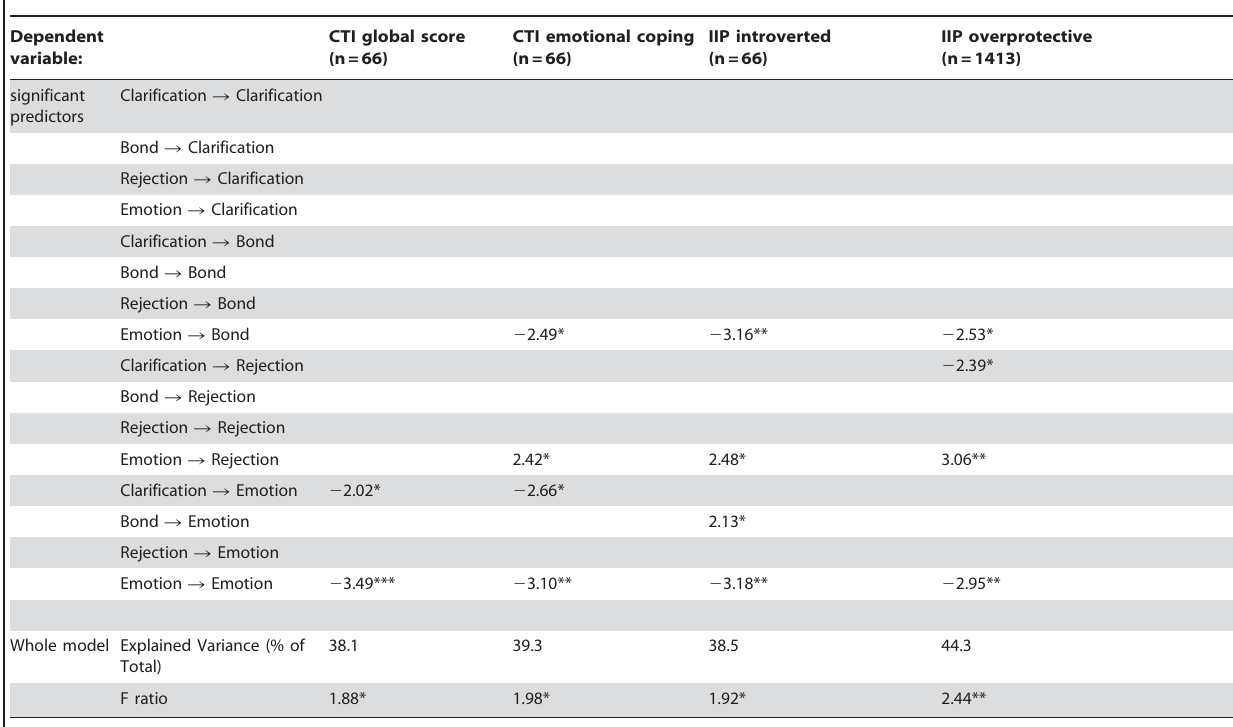
Table 3. Process-outcome